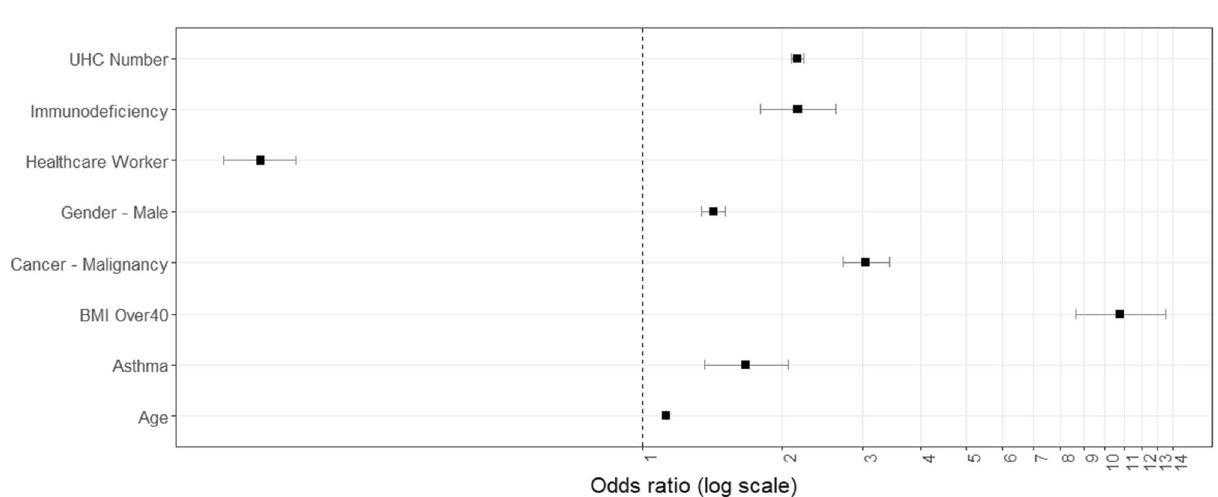
Figure 5. Forest plot of adjusted odds ratios for mortality from validated generalised linear